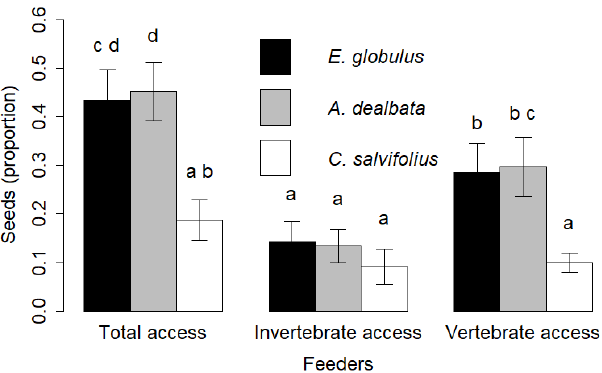
Figure 4. Proportion of seeds used (missing, eaten, elaiosome de- tached) according to the seed species and feeder type. Different let- ters above the bars indicate significant differences (post hoc pair- wise Tukey